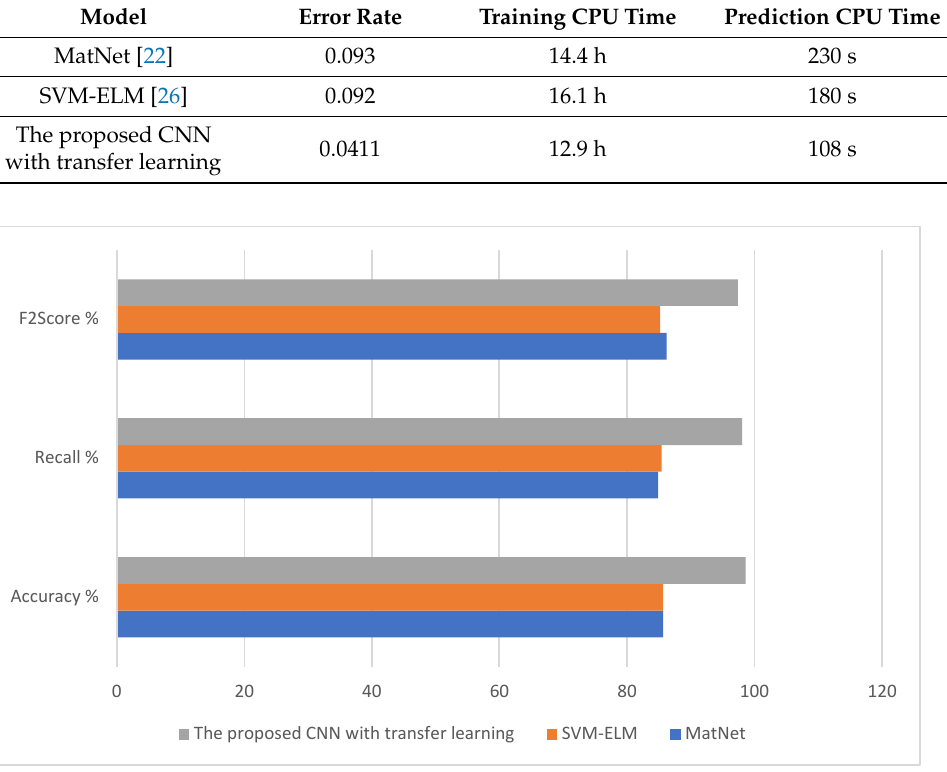
Figure 9. The performance comparison among the three models under investigation.